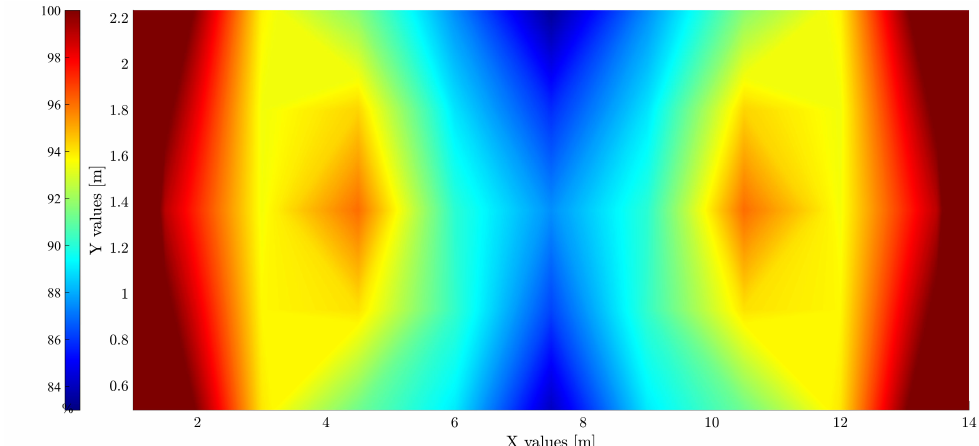
Figure 15. Percentage of plastically dissipated energy on the initial mechanical energy, supposing a constant threshold of brakes for an impacting energy of 270